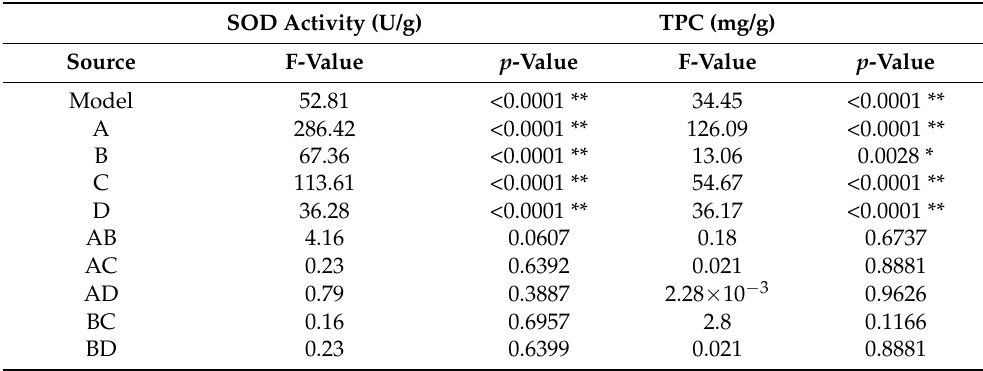
Table 4. Analysis of variance of SOD activity and TPC in